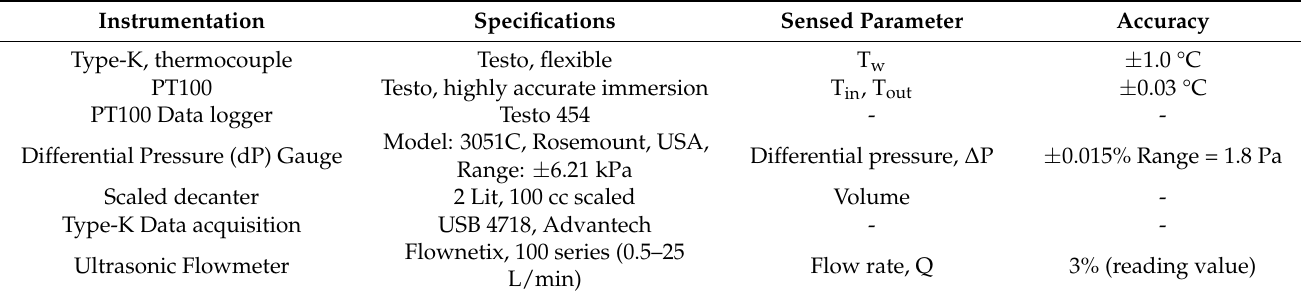
Table 1. Instrumentation and apparatuses with their resolution [28–30].